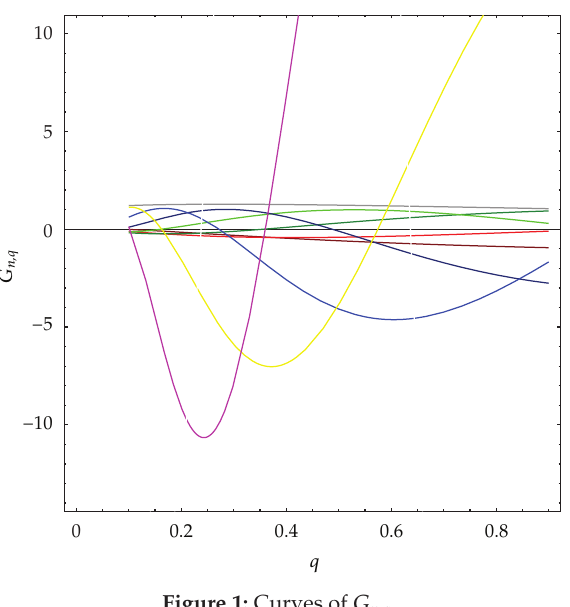
Figure 1: Curves of G n,q